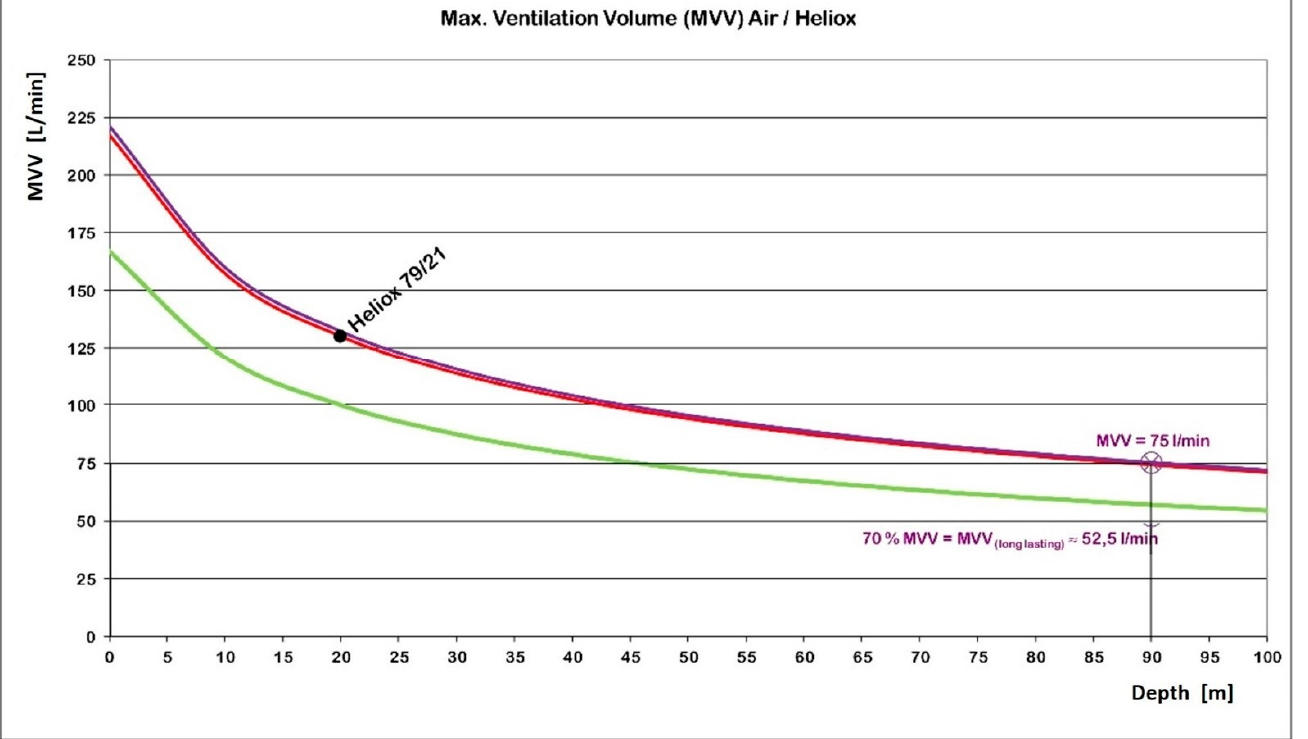
Figure 7. Depth-dependent maximum ventilation values (MVV) for heliox 79/21 (red). This curve was extrapolated from one single value (MVV: 130 L/min; depth: 20 m) [19] using Equation (2). The MVV for heliox 86/14 (blue) is shifted upwards somewhat, because that mix is less dense and viscous. The green curve represents respiration values during very severe work.